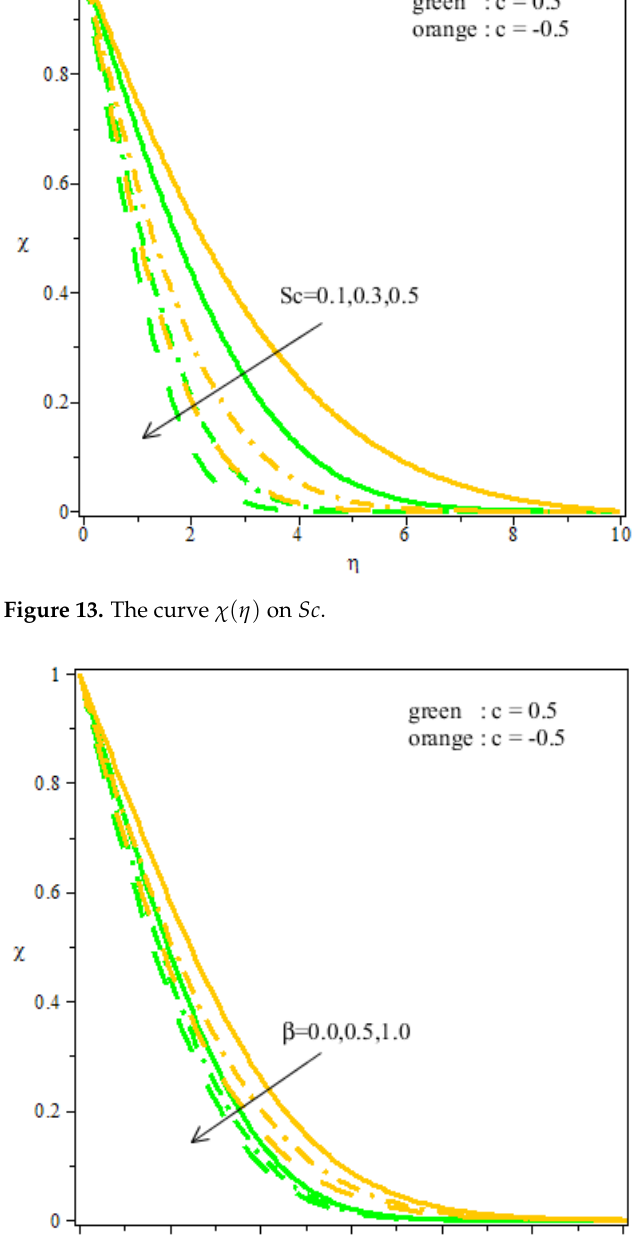
Figure 14. The curve χ ( η ) on β